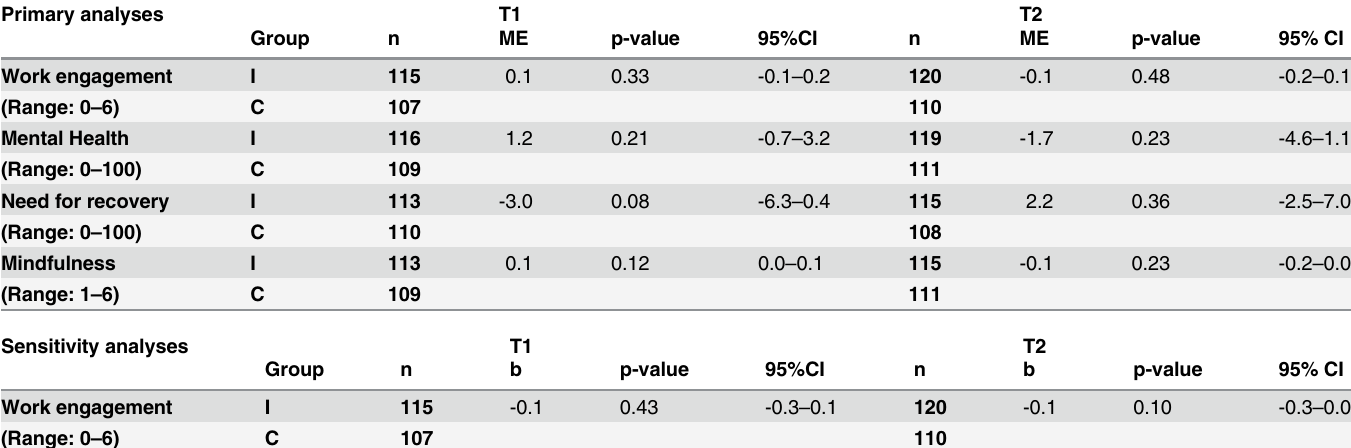
Table 3. Intervention effects on work engagement, mental health, need for recovery and mindfulness after 6 (T1) and 12 months (T2), corrected for baseline values (T0); results from linear mixed effect models (primary analyses) and linear regression models (sensitivity analyses). Primary